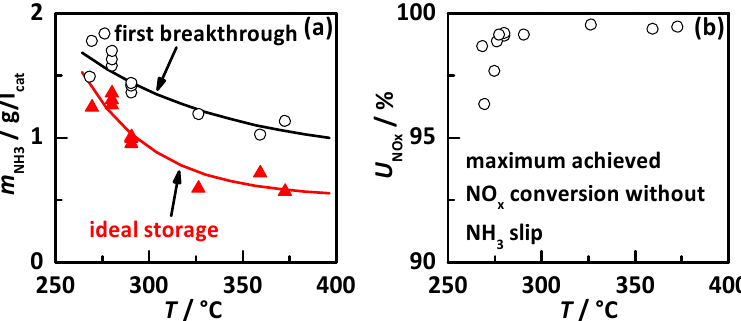
Figure 6. NH 3 storage behavior of Cu-SSZ-13 with ( a ) the ideal storage degree (lowest storage for maximum conversion, red triangles) and the storage at first breakthrough at continuous urea dosing with a previously NH 3 free catalyst (black circles) and ( b ) the maximum achieved NO x conversion as a function of catalyst temperature.